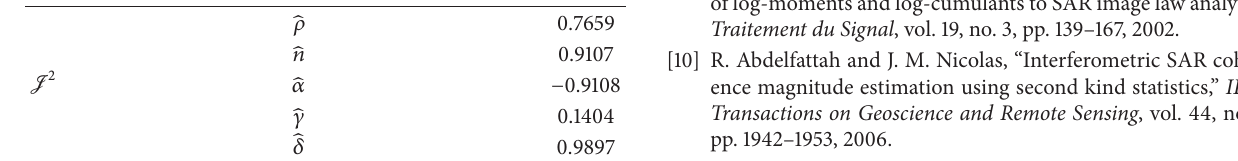
Table 1: Parameter estimations of noted clutter areas in Figure